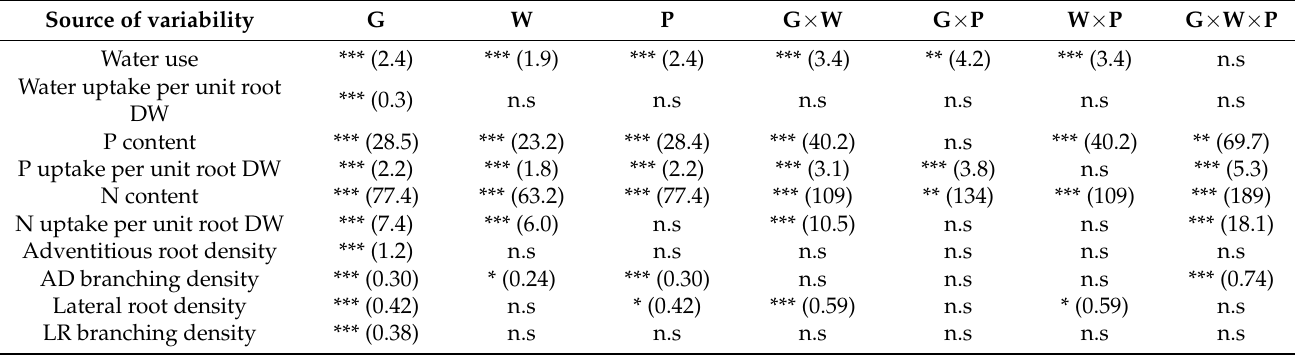
Table 2. Effect of genotype (G), water treatment (W), P level (P), and their interactions on water use (kg plant − 1 ),